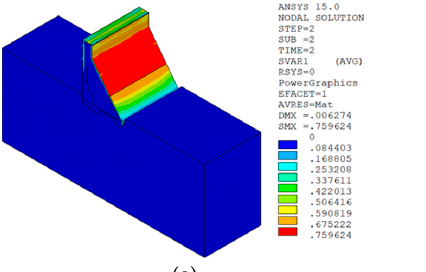
Figure 23. The temperature damage distribution of the dam is calculated by the macro model under the temperature drop condition, ( a ) Nephogram of temperature damage distribution of the dam, ( b ) Nephogram of temperature damage distribution of section z = 21 m. The three principal strain cloud charts on the section z = 21 m along the dam axis are shown in Figure 24.